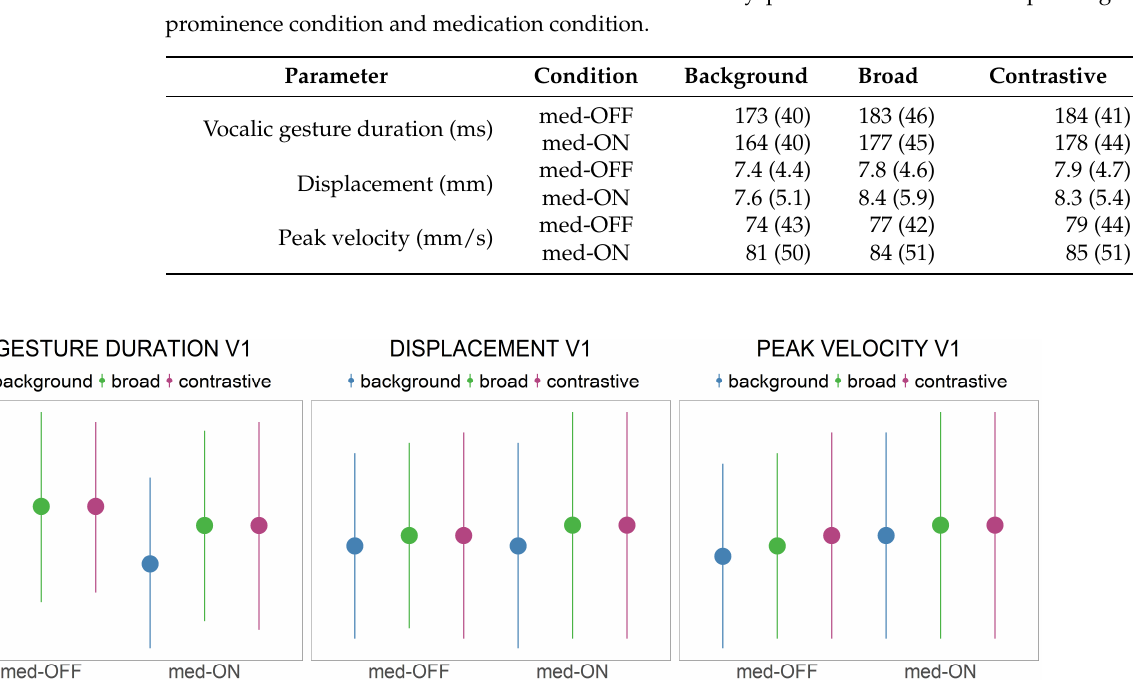
Table 4. Means and standard deviations for articulatory parameters of interest depending on prominence condition and medication condition.